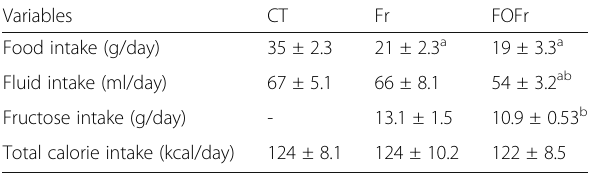
Table 3 Food, fluid, fructose, and calorie